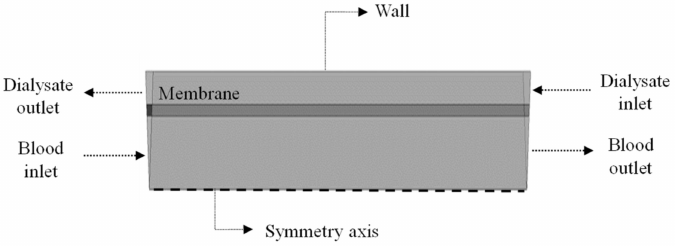
Figure 4. Domain boundaries under